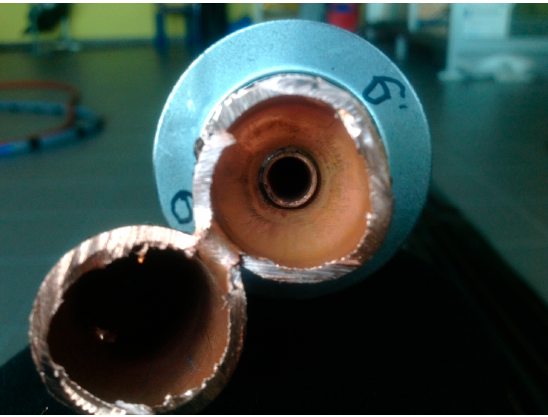
Figure 21. Condenser connection to the adiabatic pipe: ( a )—correct, ( b )—incorrect.